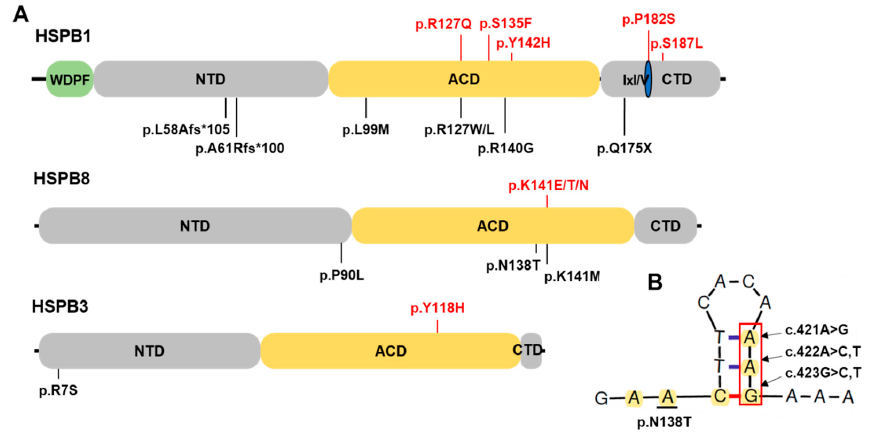
Figure 3. Schemes of three small heat shock proteins and predicted secondary structure of